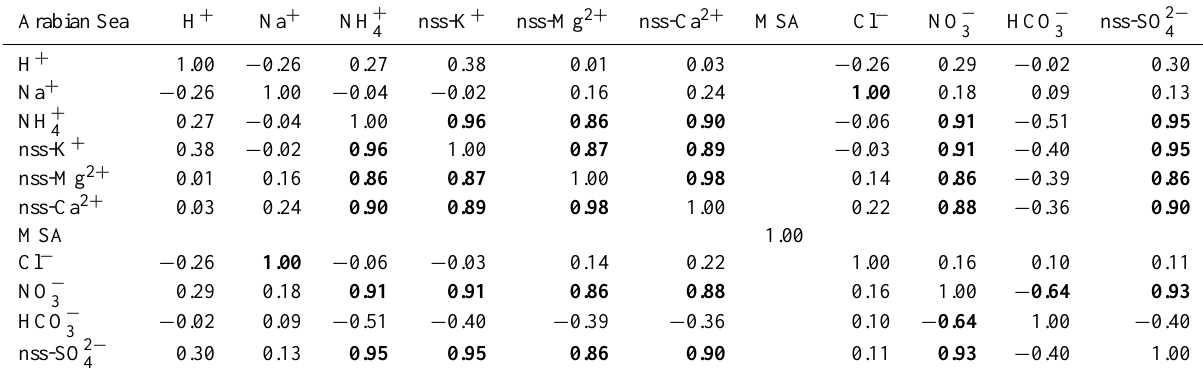
Table 6. Correlation coefficients for rainwater ionic components in the Arabian Sea trajectory group. ∗ Bold font indicates that the correlation is significant at 95% level.